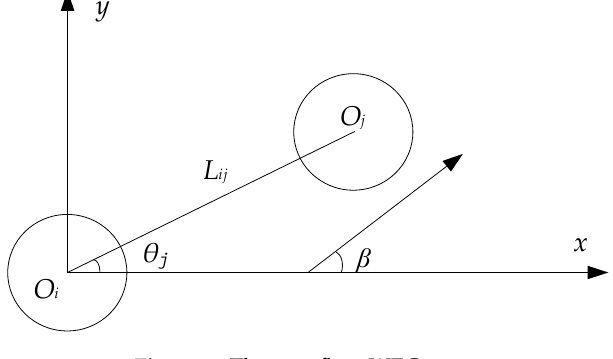
Figure 3. The two-float WEC array.